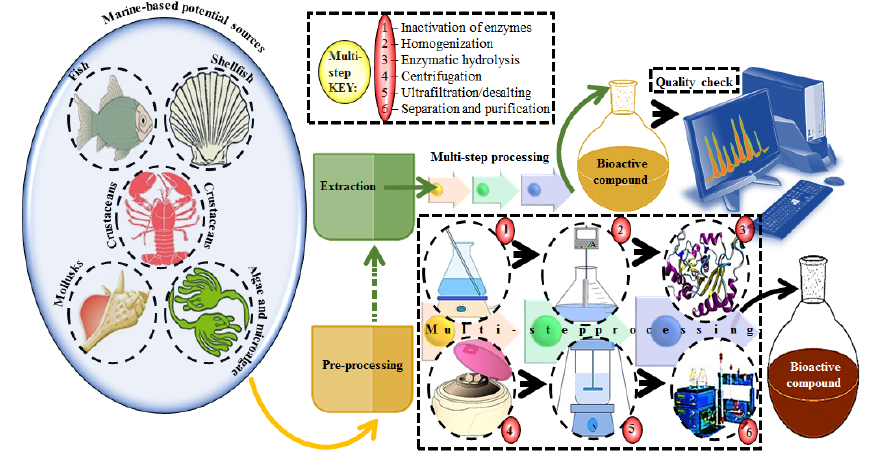
Figure 7. A stepwise illustration to extract and purify bioactive compounds from marine-based